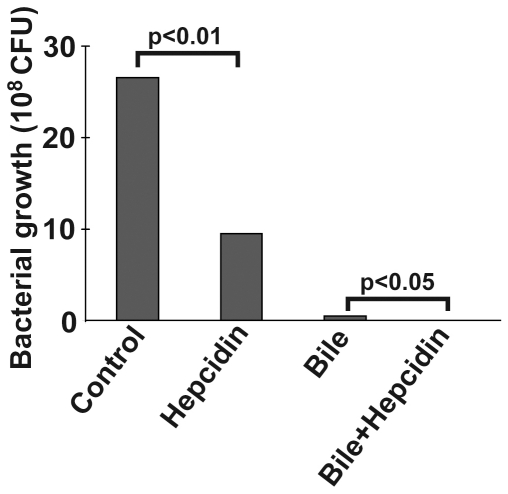
Hepcidin enhanced the antimicrobial capacity of human bile.To quantify the antimicrobial properties of human hepcidin and biliary juice, E. coli bacteria were brought to the exponential growth phase and incubated with both agents alone or in combination for 1 hour. Serial dilutions of the resulting bacterial cultures were generated and grown on agar plates for 24 hours at 37°C to allow for formation of colonies. Note that hepcidin exhibited significant antibacterial properties and further increased the antibacterial capacity of human bile juice.